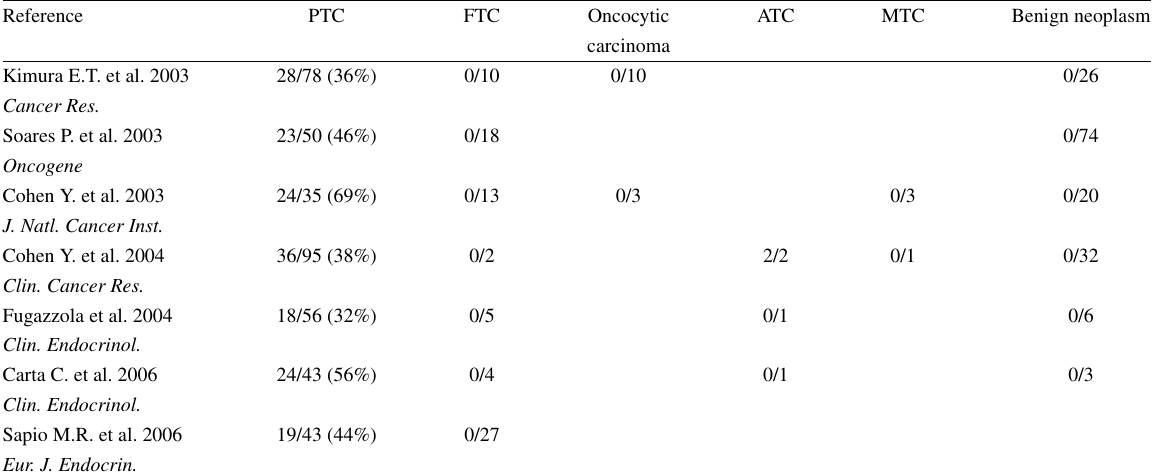
Prevalence of the BRAF T1799A mutation in thyroid